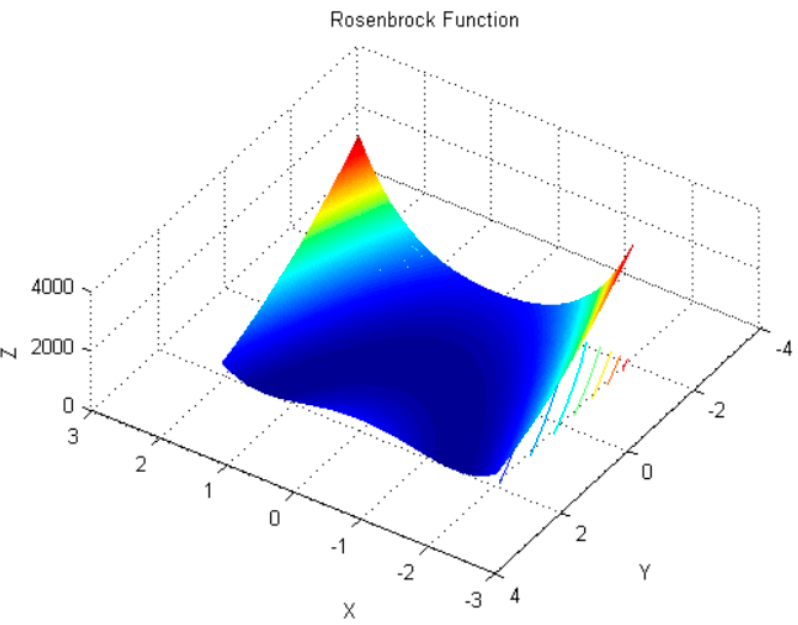
Figure 6. Three-dimensional graph of the Rosenbrock function.